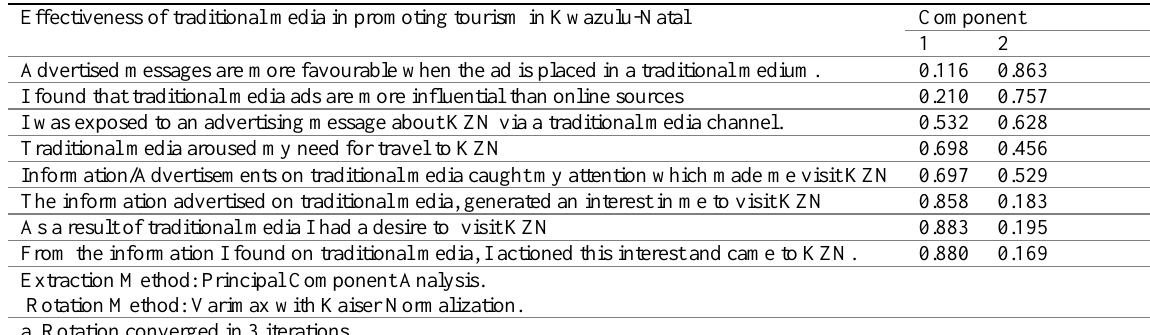
Table 3: Rotated Component Matrix : Effectiveness of traditional